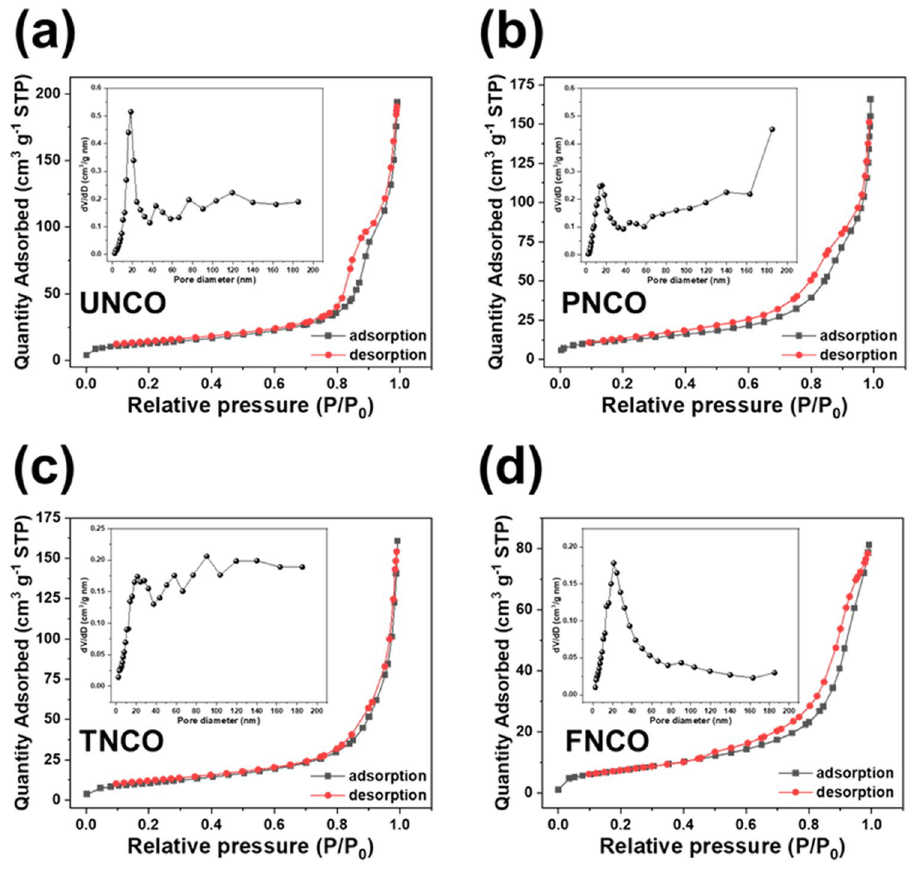
Figure 4. BET results of ( a ) UNCO, ( b ) PNCO, ( c ) TNCO, and ( d ) FNCO. The insets show the corresponding pore size distributions.